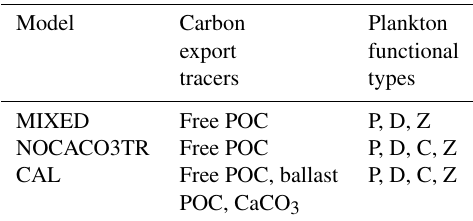
Table 1. Summary of ecosystem components for each model con- figuration. Abbreviations are as follows: particulate organic carbon (POC), calcium carbonate (CaCO 3 ), mixed phytoplankton (P), dia- zotrophs (D), zooplankton (Z), and small phytoplankton and calci- fiers